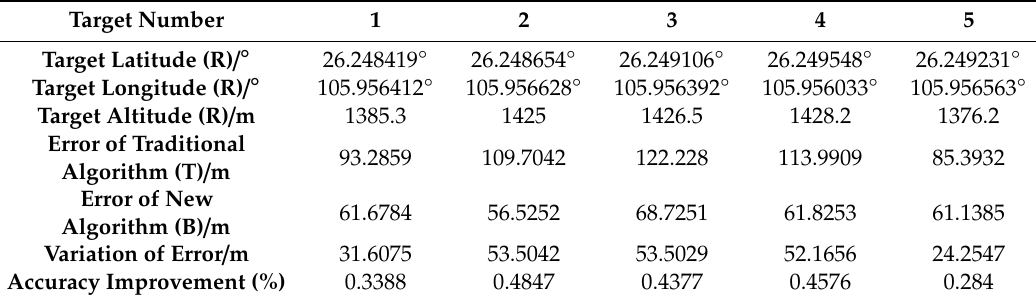
Table 4. Positioning results of Figure 16.